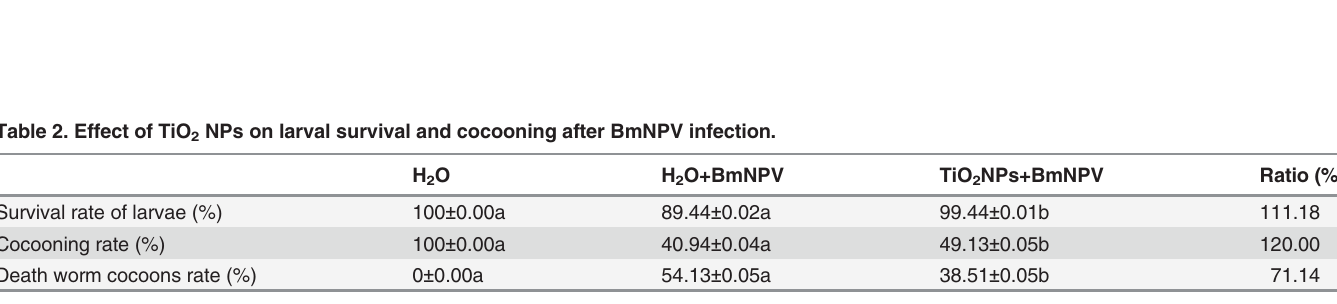
The ratio represents the ratio of TiO 2 NPs+BmNPV to H 2 O+BmNPV. Ranks marked with different letters mean they were signi fi cantly different at the 5% con fi dence level. Values represent means ± SD.